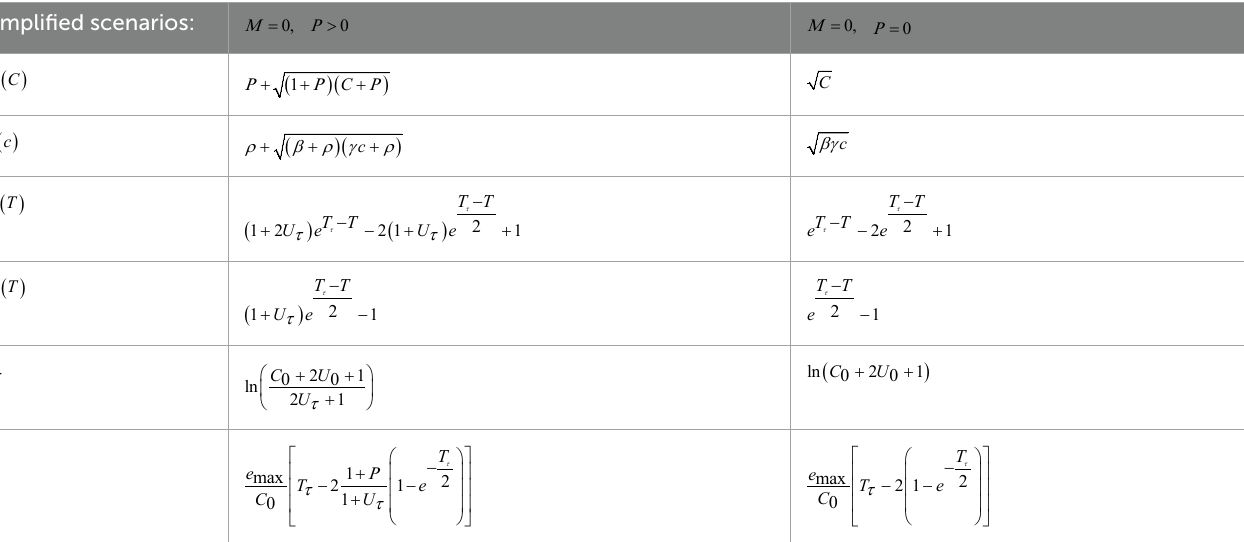
TABLE 2 Analytical solutions of the optimal decomposition problem when 0 =M or